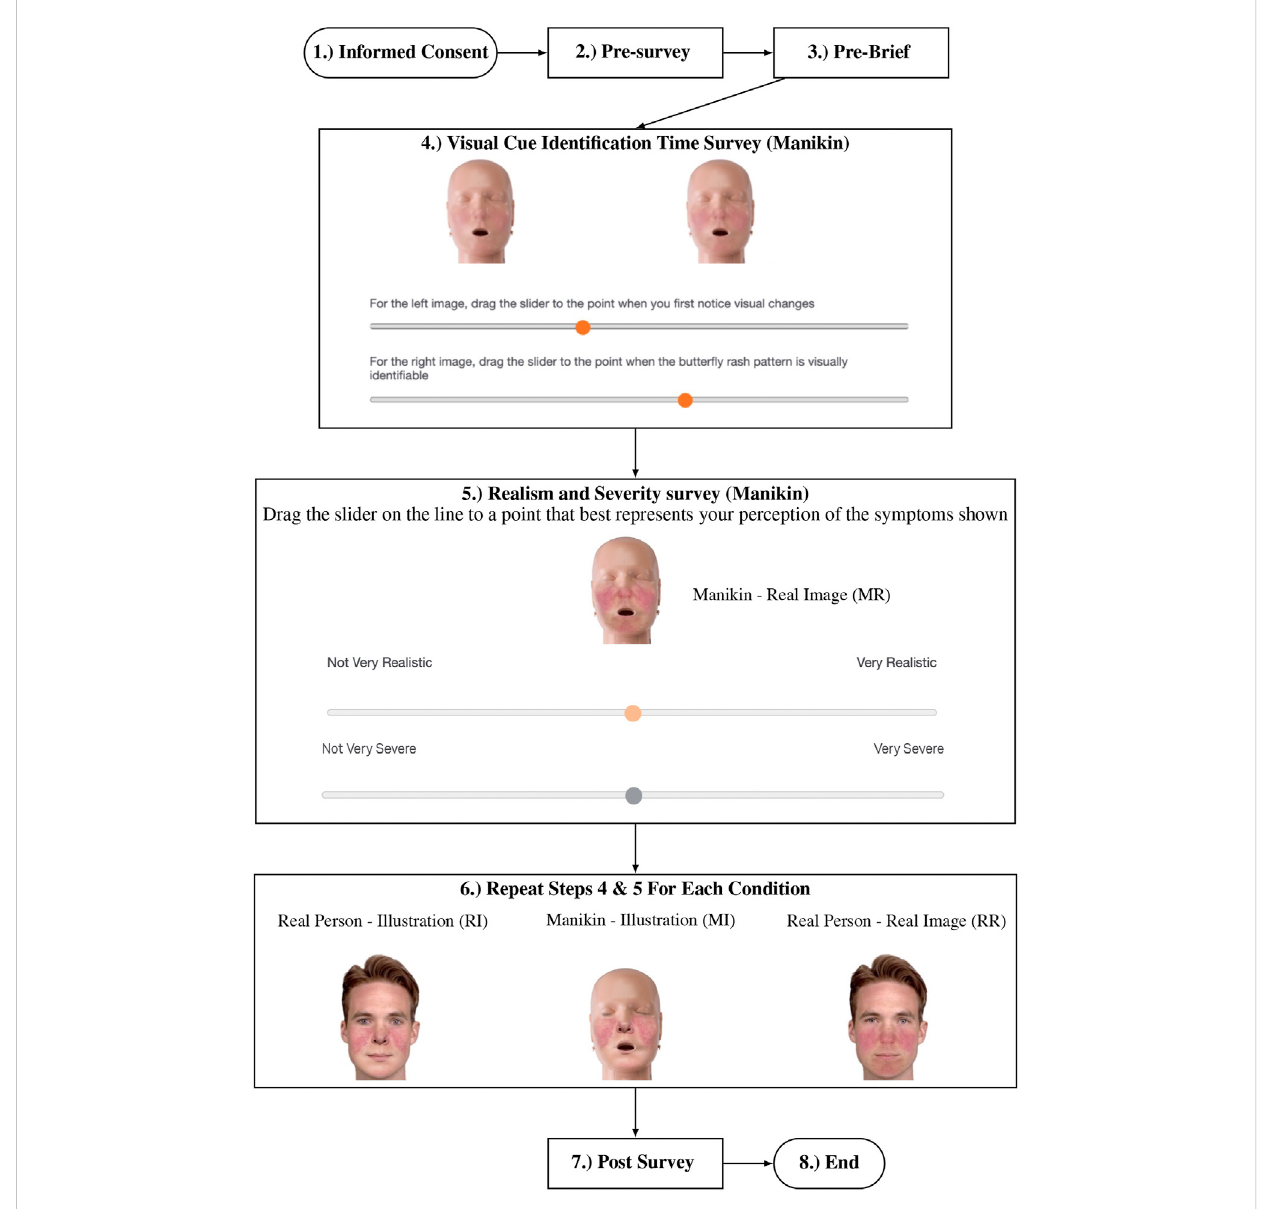
FIGURE 2 Procedure followed by participants in the study. The conditions are labeled above: Real Person-Illustration Filter (RI), Real Person-Real Image Filter (RR), Manikin-Illustration Filter (MI), and Manikin-Real Image Filter (MR).